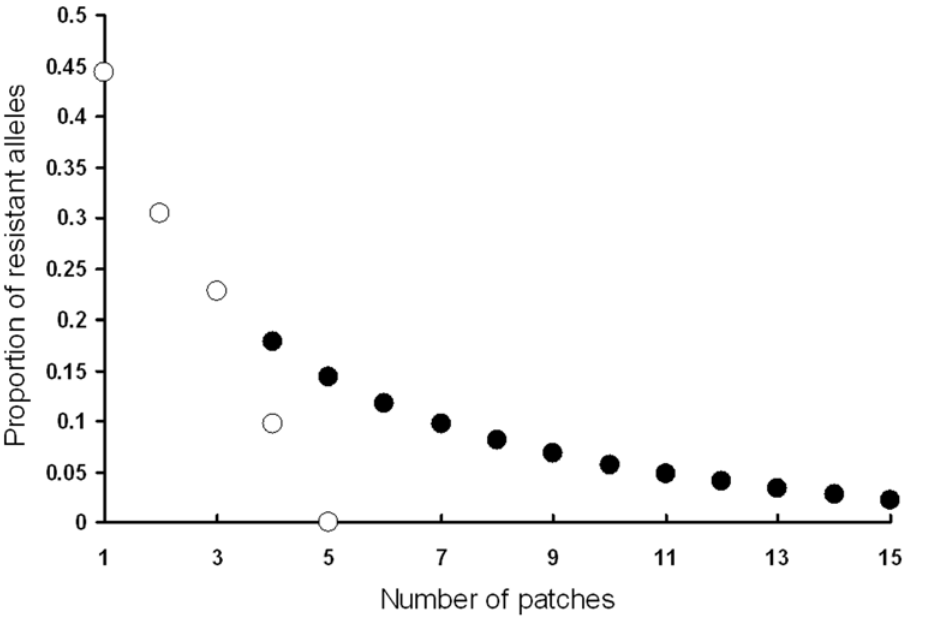
Figure 5. Decline in resistance evolved as the spatial division increases (filled dot: all patches are connected; empty dot: only neighboring patches are connected). Spatial structuring slows the rate of resistance evolution and also reduces the equilibrium level of resistance. Comparing spatial structures of different connectivity shows that the greater the connectivity, the greater the equilibrium level of host resistance. When the density of hosts is decreased, epidemic size is reduced, thus the selection for host resistance is lowered.